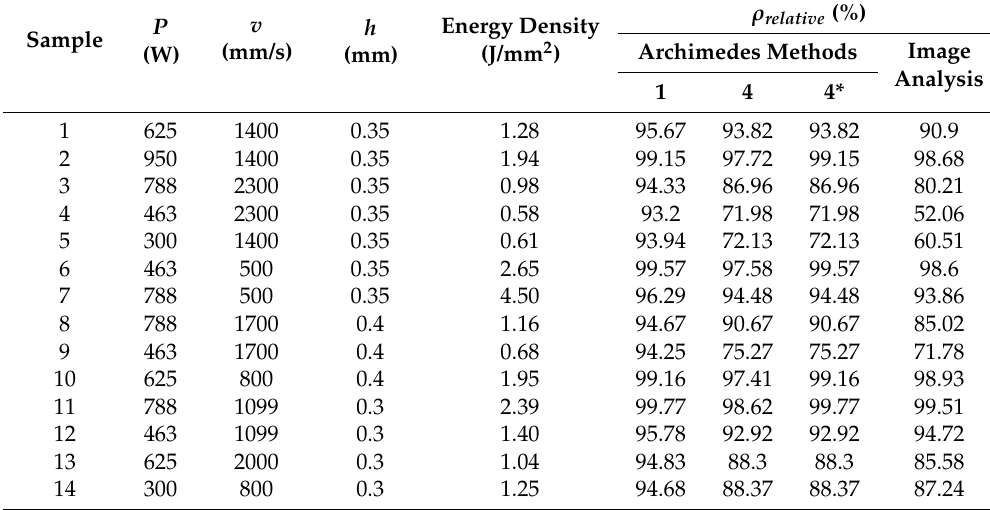
Table 5. Relative density